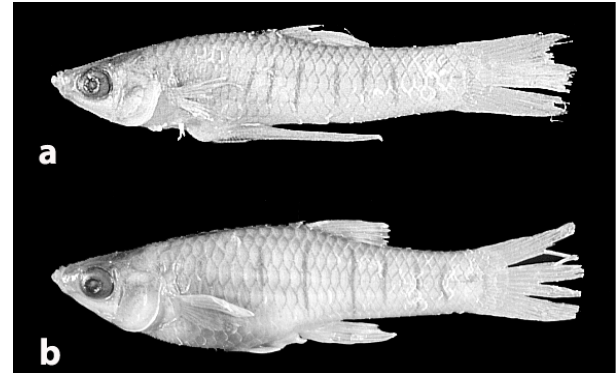
Fig. 6. Tukey box plot of number of bars along flanks in fe- male specimens of Phalloptychus januarius and P . iheringii . Significant differences were found between P . januarius (Rio de Janeiro, São Paulo and Paraná) and P . iheringii popula- tions (Santa Catarina and Rio Grande do Sul). * Type locality of P . januarius , ** type locality of P . iheringii . Description. Morphometric data in Tables 1-2. Range of SL: 18.4 to 32.6 mm (females), 13.6 to 19.8 mm (males). Body com- pressed; width in predorsal region uniform, and about half body depth. Postdorsal region compressed towards caudal peduncle. Dorsal profile of head slightly concave. Predorsal profile convex. Dorsal-fin base oblique. Postdorsal profile concave. Pre-anal profile convex. Anal-fin base oblique; post- anal profile slightly concave. Dorsal fin with semi-elliptical border, located posterior to mid-body. Origin of dorsal fin in females at vertical passing approximately through base of second anal-fin ray; in males, origin of dorsal fin posterior to vertical passing through origin of anal fin. Pectoral fin with high insertion. Base of dorsalmost pectoral-fin ray closer to dorsal than to ventral profile. Longest pectoral-fin ray of fe- males reaching about fifth or sixth scale in longitudinal se- ries. In adult males, origin of pectoral fin aligned with origin of pelvic fin. Pelvic fin small, surpassing origin of gonopodium in male; not reaching origin of anal fin in females. Origin of anal fin of male closer to snout tip than to caudal peduncle. Mouth superior, almost aligned with base of dorsalmost pec- toral-fin ray.